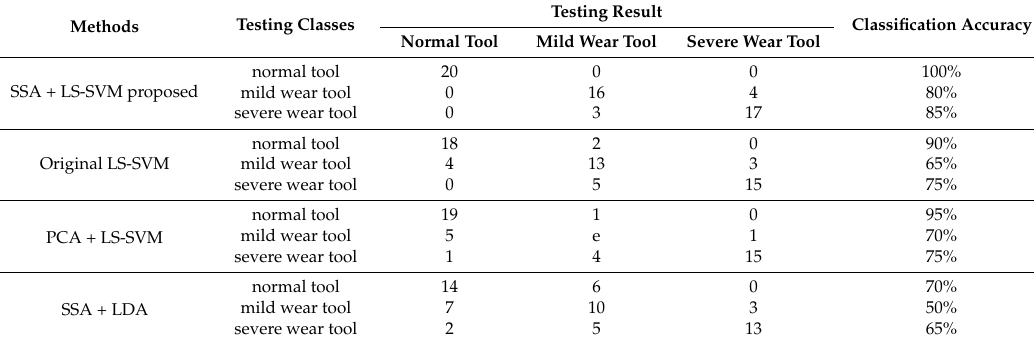
Table 3. Result of SSA + LS-SVM, original LS-SVM, PCA + LS-SVM and SSA + LDA with testing